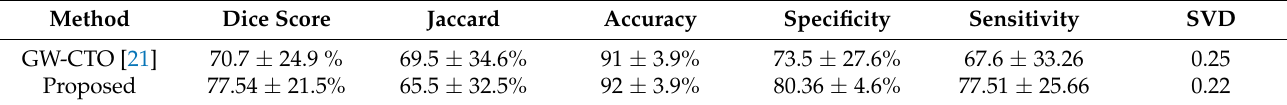
Table 3. Segmentation Results on Silver07